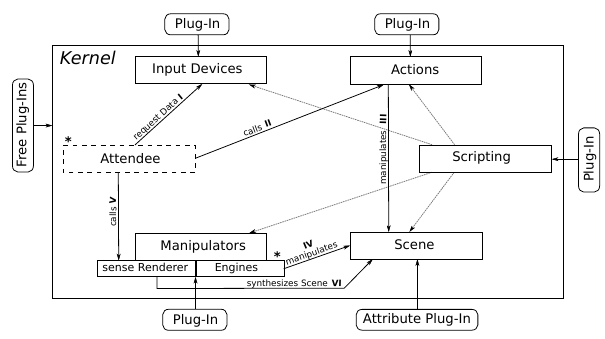
Fig. 1. Kernel sketch with the plug-in interfaces. The numbered lines show the calling order of the single components during one main-loop cycle. Objects marked with (*) are called through the main loop